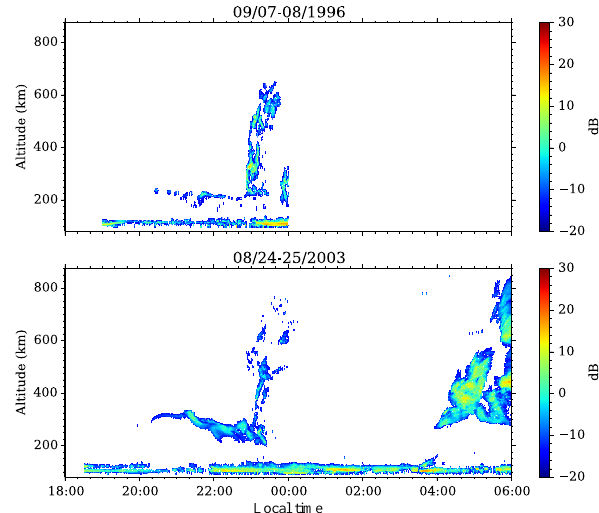
Figure 6. Two of the Fig. 5 events are shown, which we believe are similar to those in Figs. 1 and 2. These events occurred under mod- erate magnetic activity. The Kp indices are 3 (top) and 5